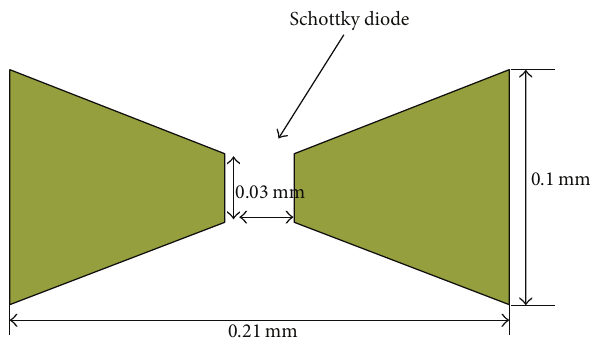
Figure 4: Geometry of the bow-tie element.